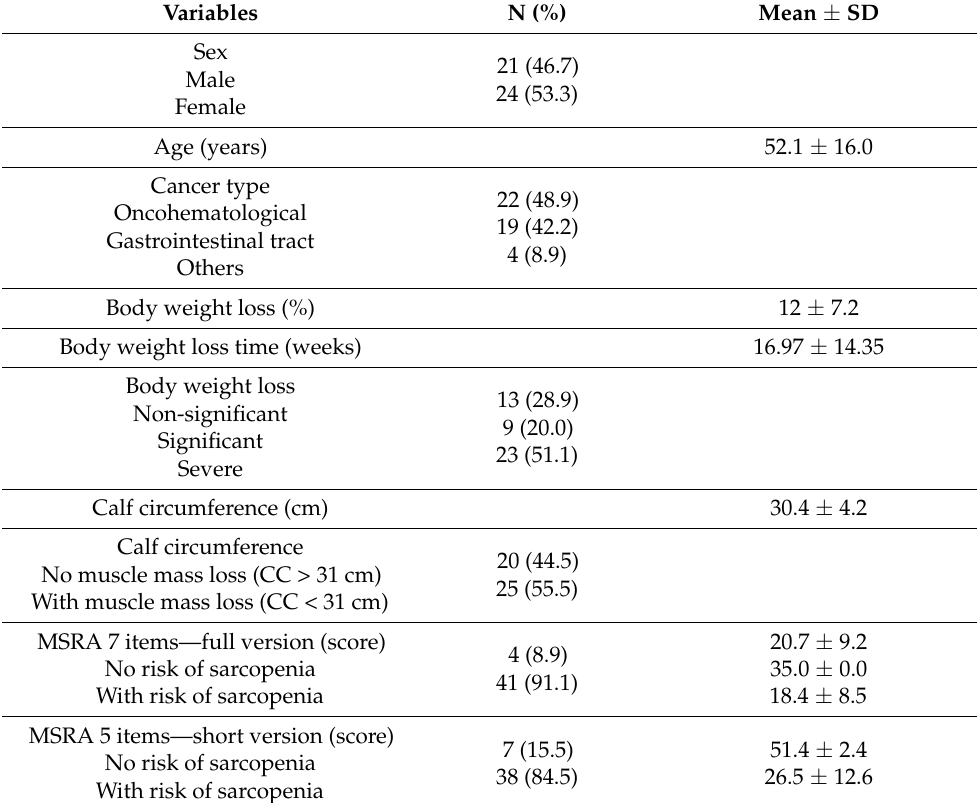
Table 1. Social, clinical, and anthropometric characteristics of